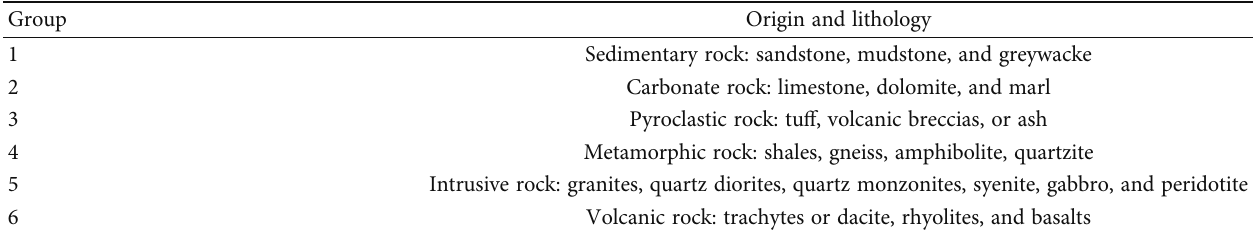
Figure 2: Topographic factors mapping of the study area: (a) elevation; (b) slope aspect; (c) slope degree; (d) terrain curvature; (e) plane curvature; (f) pro fi le curvature; (g) surface roughness; (h) landform; (i) lithology. Table 2: Classi fi cation of lithologic